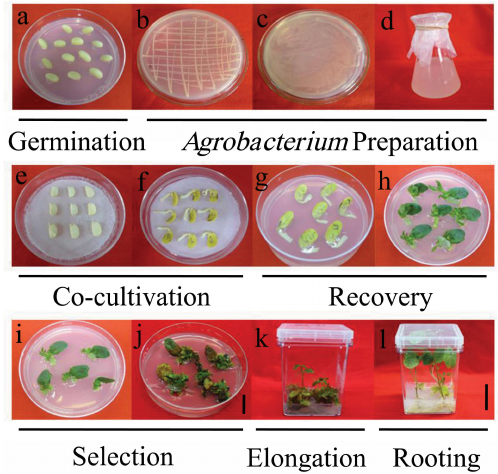
Figure 6. The process of Agrobacterium -mediated soybean half-seed transformation. ( a ) Germination; ( b – d ) Agrobacterium preparation; ( e ) Co-cultivation 0 day; ( f ) Co-cultivation 5 days; ( g ) Recovery 0 day; ( h ) Recovery 7 days; ( i ) Selection 0 day; ( j ) Selection 21 days; ( k )Elongation; ( l ) Rooting 7 days. Scale bars, ( a – j ) 2.5 cm; ( k , l ) 4